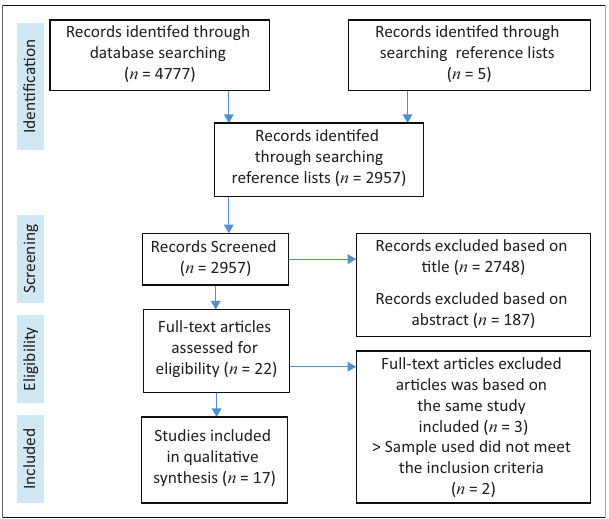
FIGURE 1: Preferred Reporting Items for Systematic Reviews and Meta-Analyses flow diagram of article inclusion and